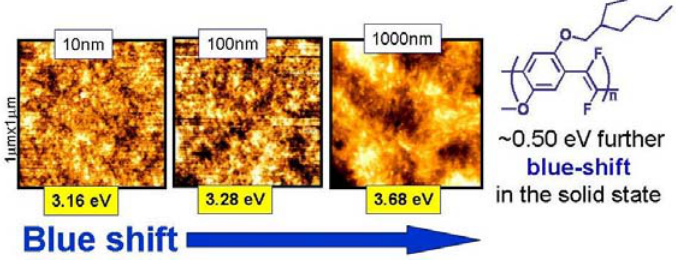
Figure 4. AFM topography of MEH-PPDFV films with different thickness and the associated energy gap values measured by spectroscopic ellipsometry.